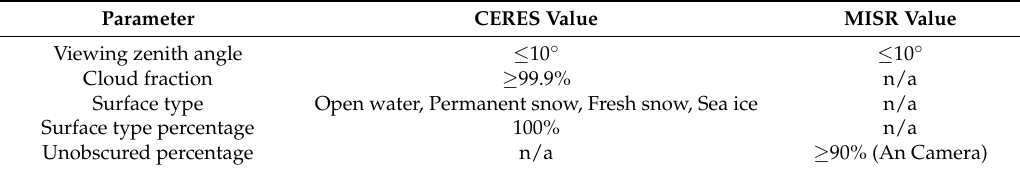
Table 2. Data selection criteria for albedo